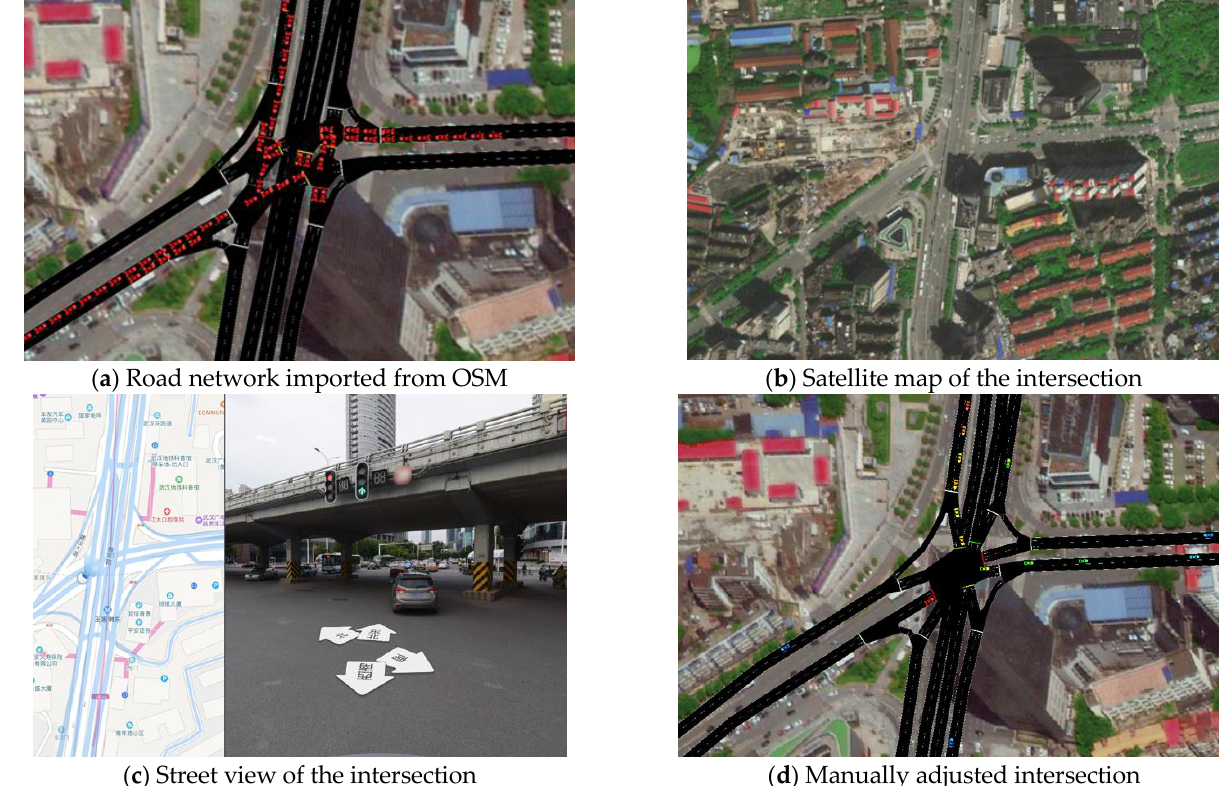
Figure 1. Manually adjustment according to actual road structure .